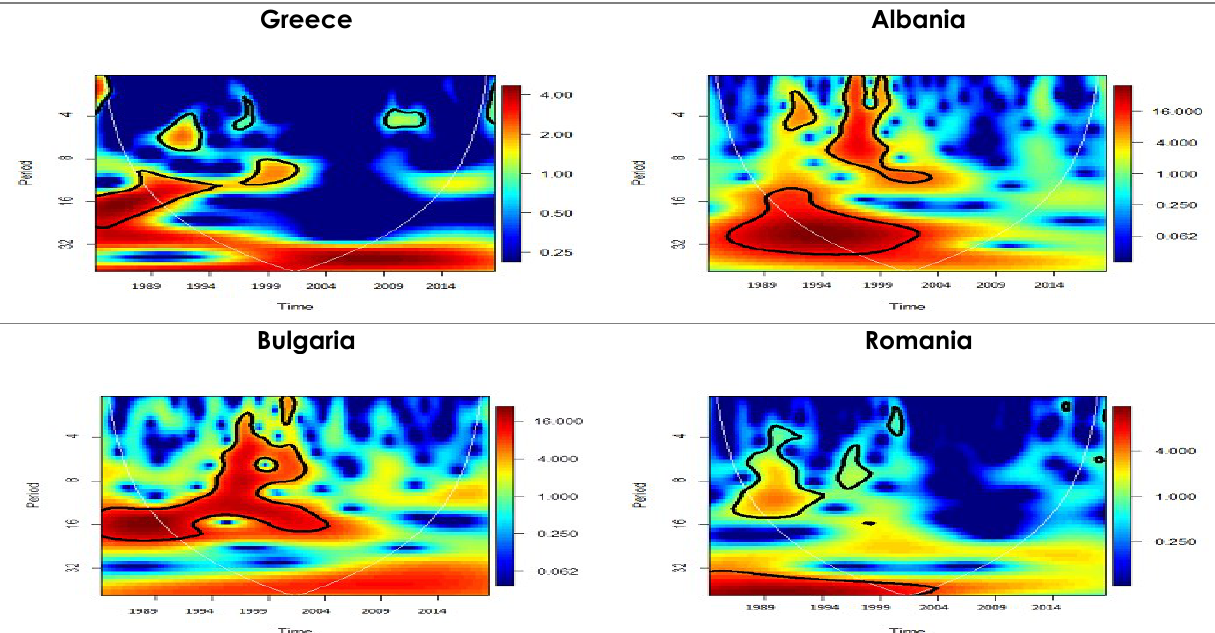
Figure 1. Wavelet Power Spectrum for Political Risk. Source: Author using Political Risk Group (2019)